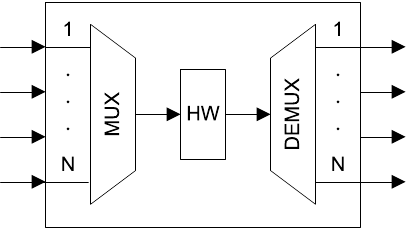
Figure 1. Hardware virtualization for N distinct data streams that perform the same computa- tion. The N streams are multiplexed into a shared hardware (HW) block, processed, and then demultiplexed back into N